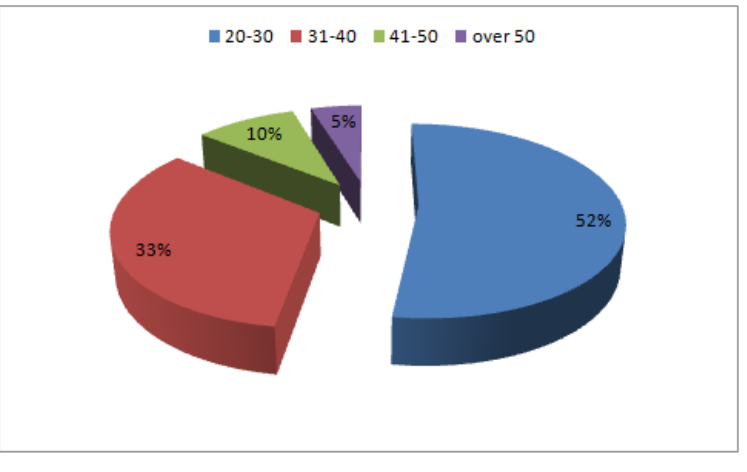
Figure 2: The Respondents' Age